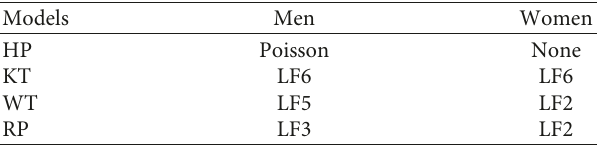
Table 3: Loss function in optimizing the parametric mortality model to obtain the fitted value for both